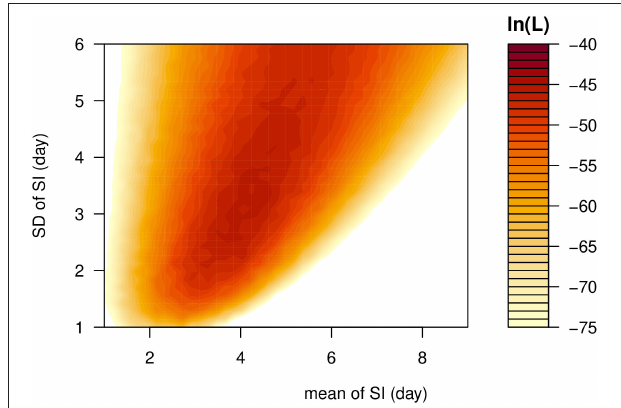
FIGURE 1 | The likelihood profile of the varying serial interval (SI) of COVID-19 by using all samples. The color scheme is shown on the right-hand side, and a darker color indicates a larger log-likelihood, i.e., ln( L ), value.